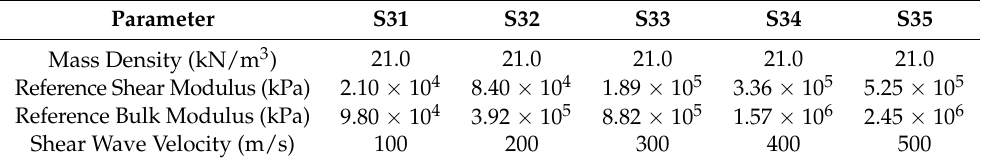
Table 3. Mesh characteristics. Table 6. S3 soil